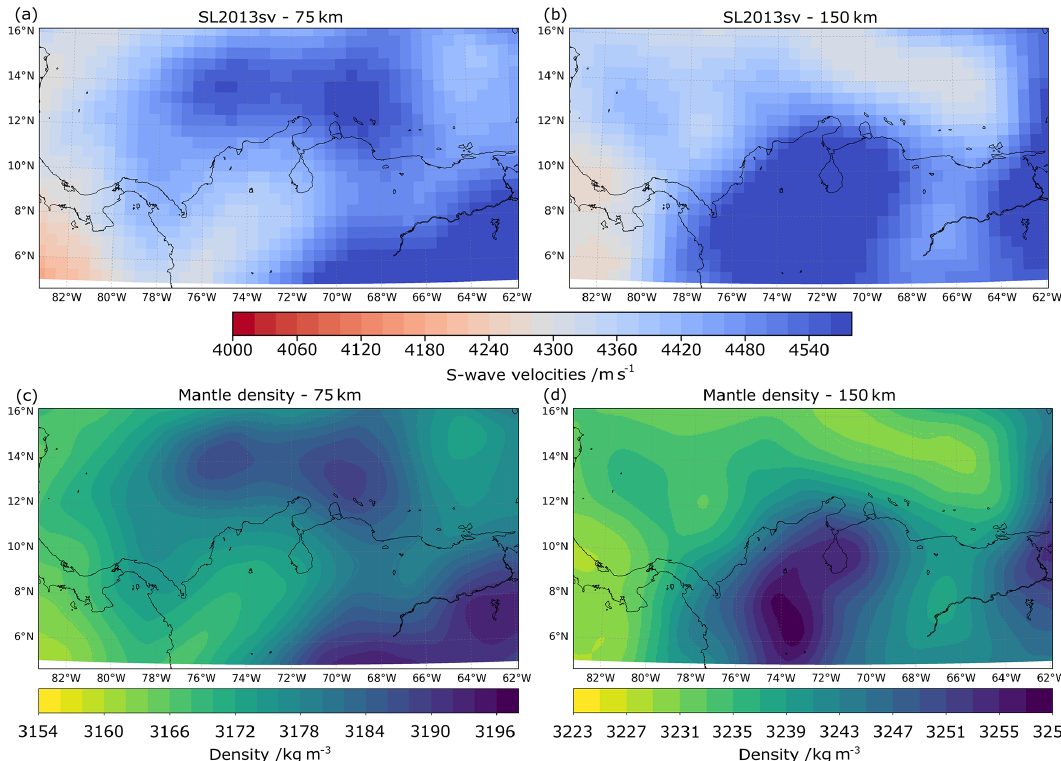
Figure 4. Relation between the S-wave velocities from the SL2013sv model (Schaeffer and Lebedev, 2013) and the calculated mantle densities. (a, b) S-wave velocities at 75 and 150km depth, respectively. The original cell size of the tomographic data is 0 . 5 ◦ × 0 . 5 ◦ . (c, d) Corresponding densities at 75 and 150km depth following Goes et al. (2000) and Meeßen (2017) (see the text for details of the conversion). In this case the S-wave velocities were interpolated to a spatial resolution of 25km to make them consistent with the spatial resolution of the rest of the lithospheric layers.